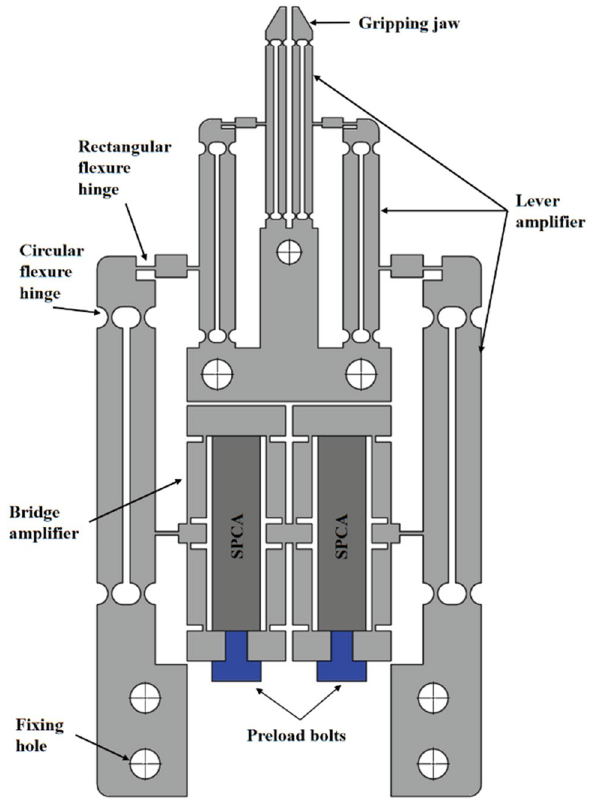
Fig. 1 Schematic diagram of the proposed